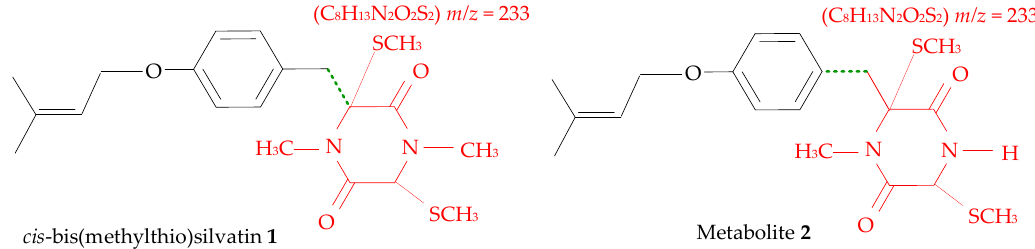
Scheme 2. Substructure colored in red has been assigned to ion C 8 H 13 N 2 O 2 S 2 + at m / z = 233 in Figure 5, while the substructure in black represents the neutral loss for its formation from the parent ion.